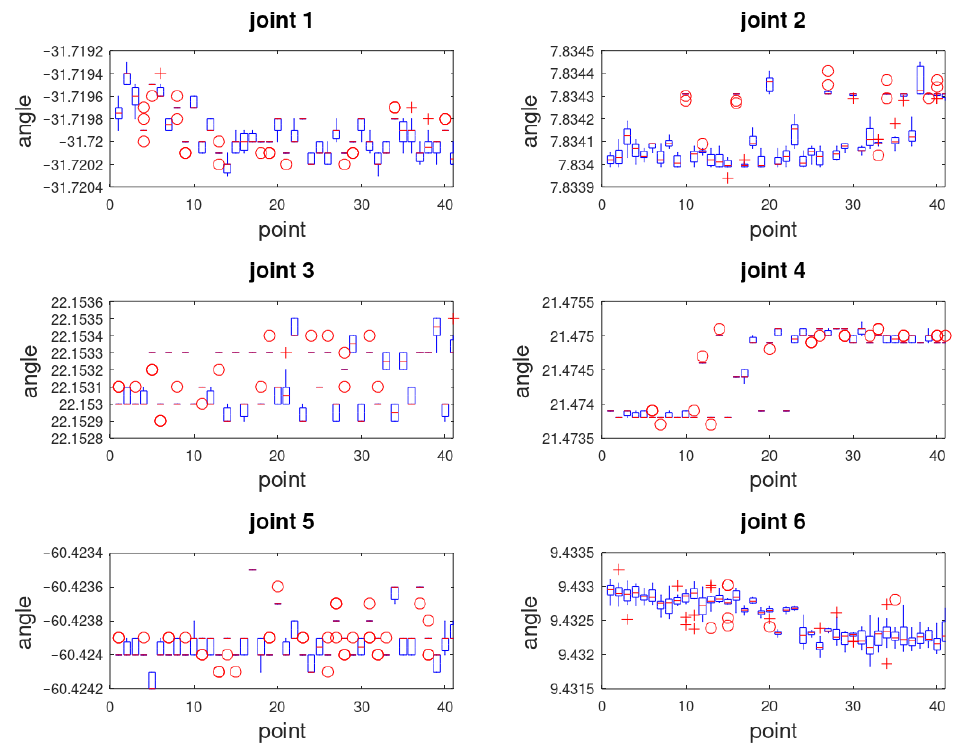
Figure 9. Error (°) distribution on individual robot joints during Measurement 14. Figure 9. Error ( ◦ ) distribution on individual robot joints during Measurement